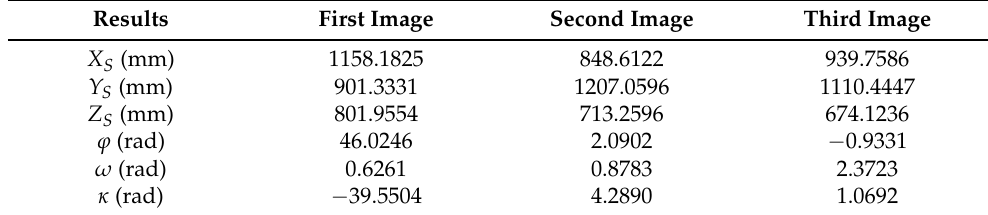
Table 4. Exterior orientation elements of three images.